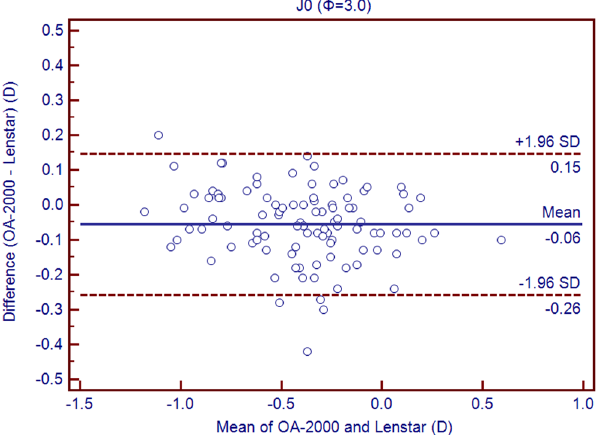
Figure 15. Bland-Altman plots show the agreement between OA-2000 swept-source optical coherence tomography and Lenstar optical low coherence reflectometry for measuring vectors J 0 at 3.0mm. Solid lines represent the bias between both devices and dotted lines represent at the 95% confidence interval for the